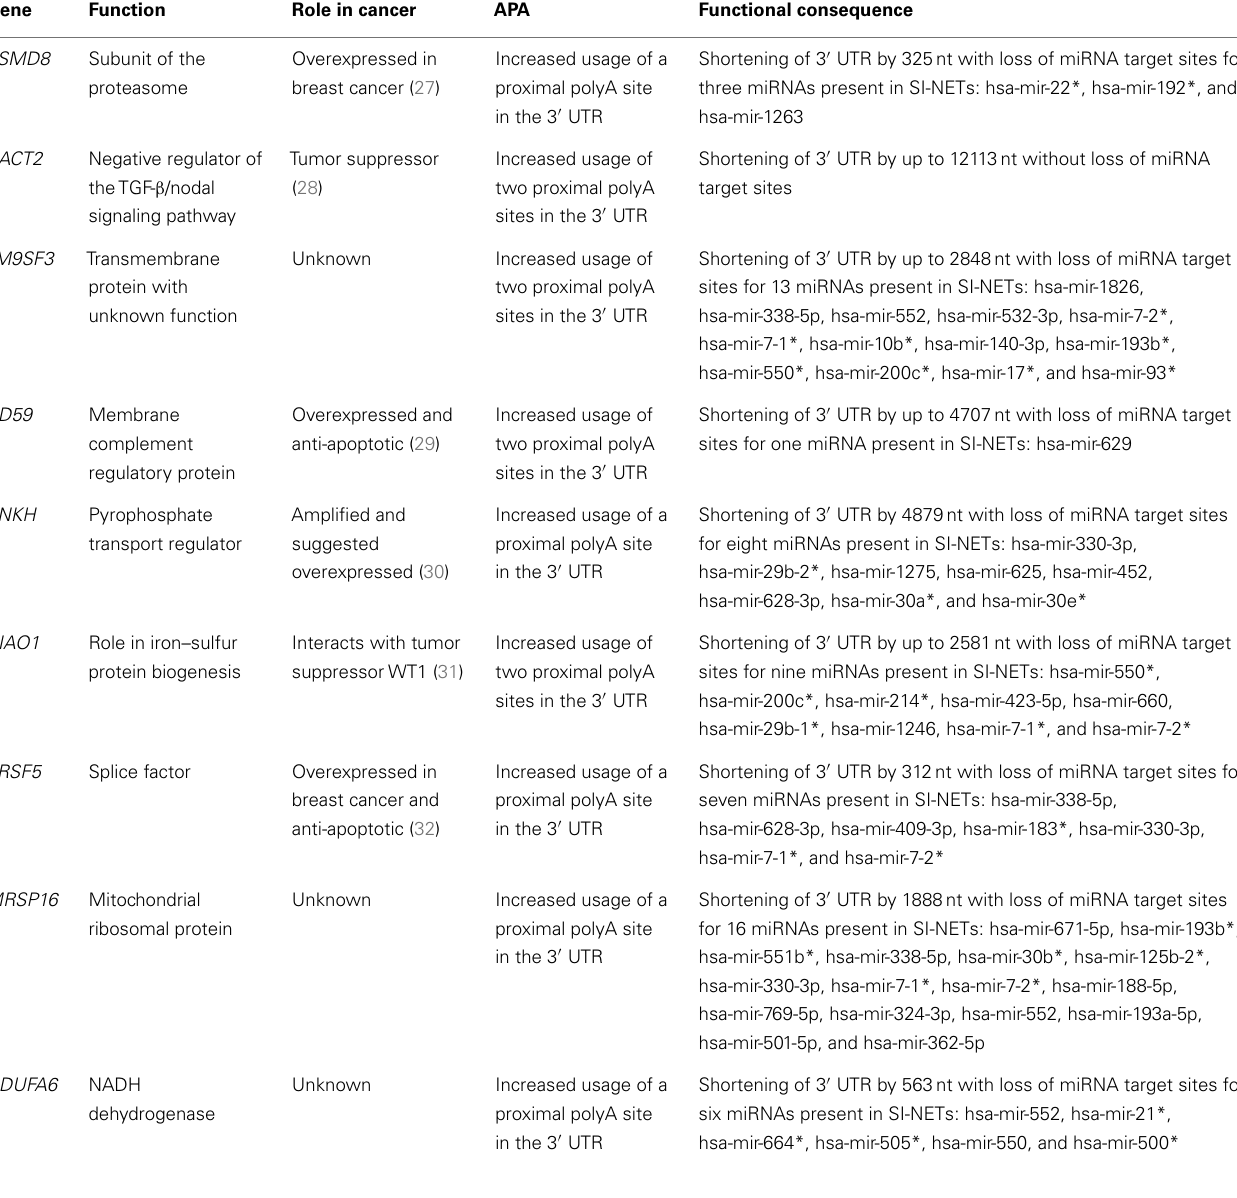
Table 3 | Genes with UTR-APA specific to the